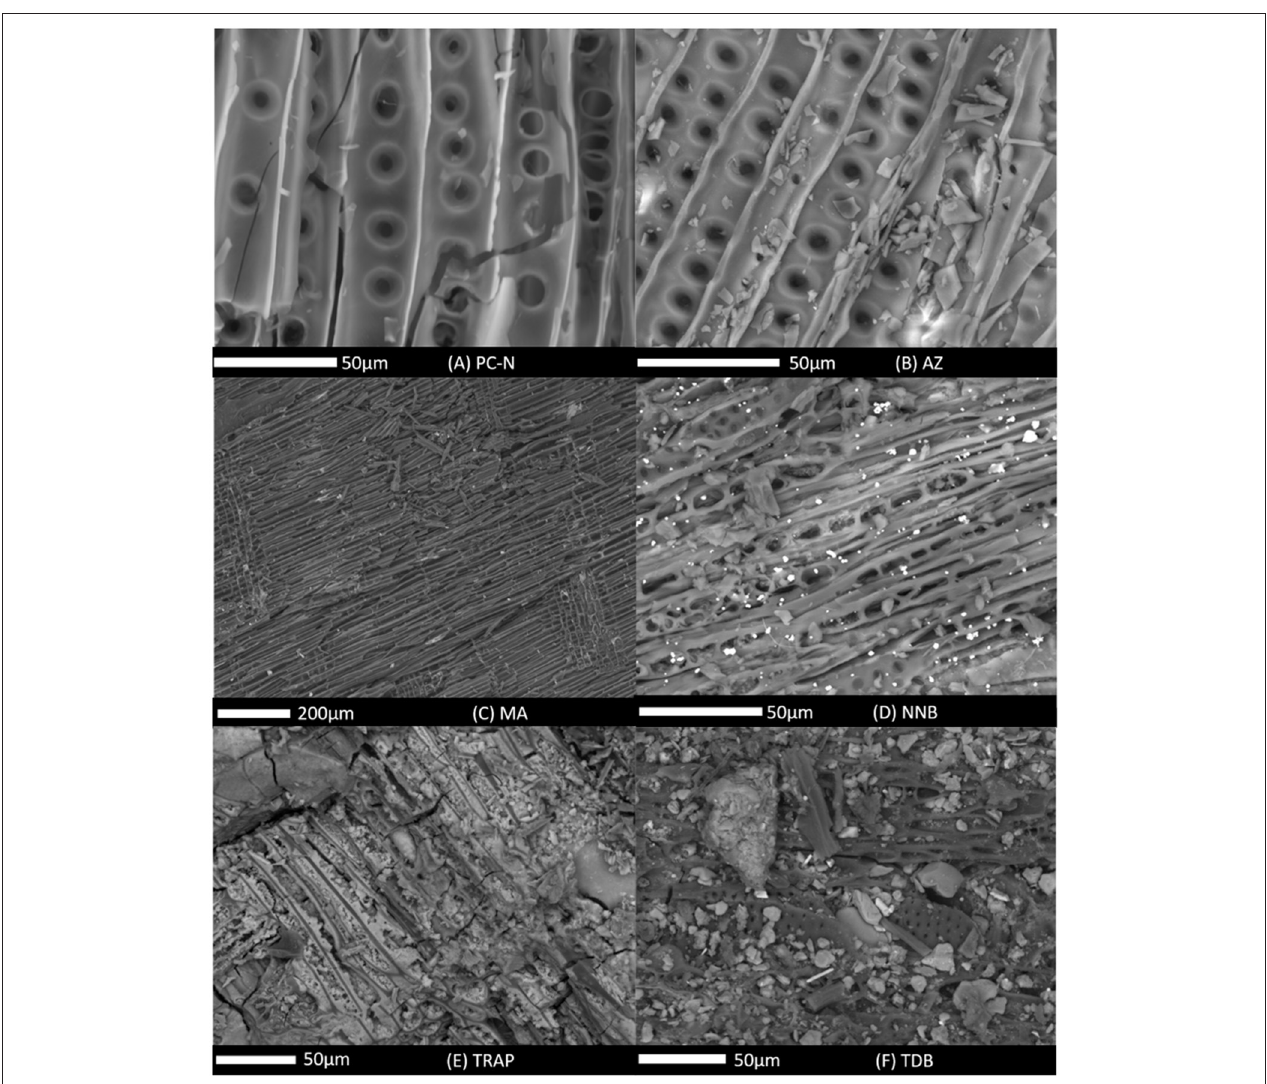
FIGURE 5 | Scanning Electron Microscopy images for all samples analyzed, showing areas that are representative of the overall structure of the specimen. Images are ordered: (A) PC-N; (B) AZ; (C) MA; (D) NNB; (E) TRAP; (F) TDB. PC-N and AZ show bordered pits in longitudinal fracture of conifer wood; MA shows radial longitudinal fracture of conifer wood with rays (e.g., right of image); NNB shows tangential longitudinal fracture of conifer wood with uniseriate and biseriate rays; TRAP and TDB show little plant anatomy (see text) due to presence of mineral.